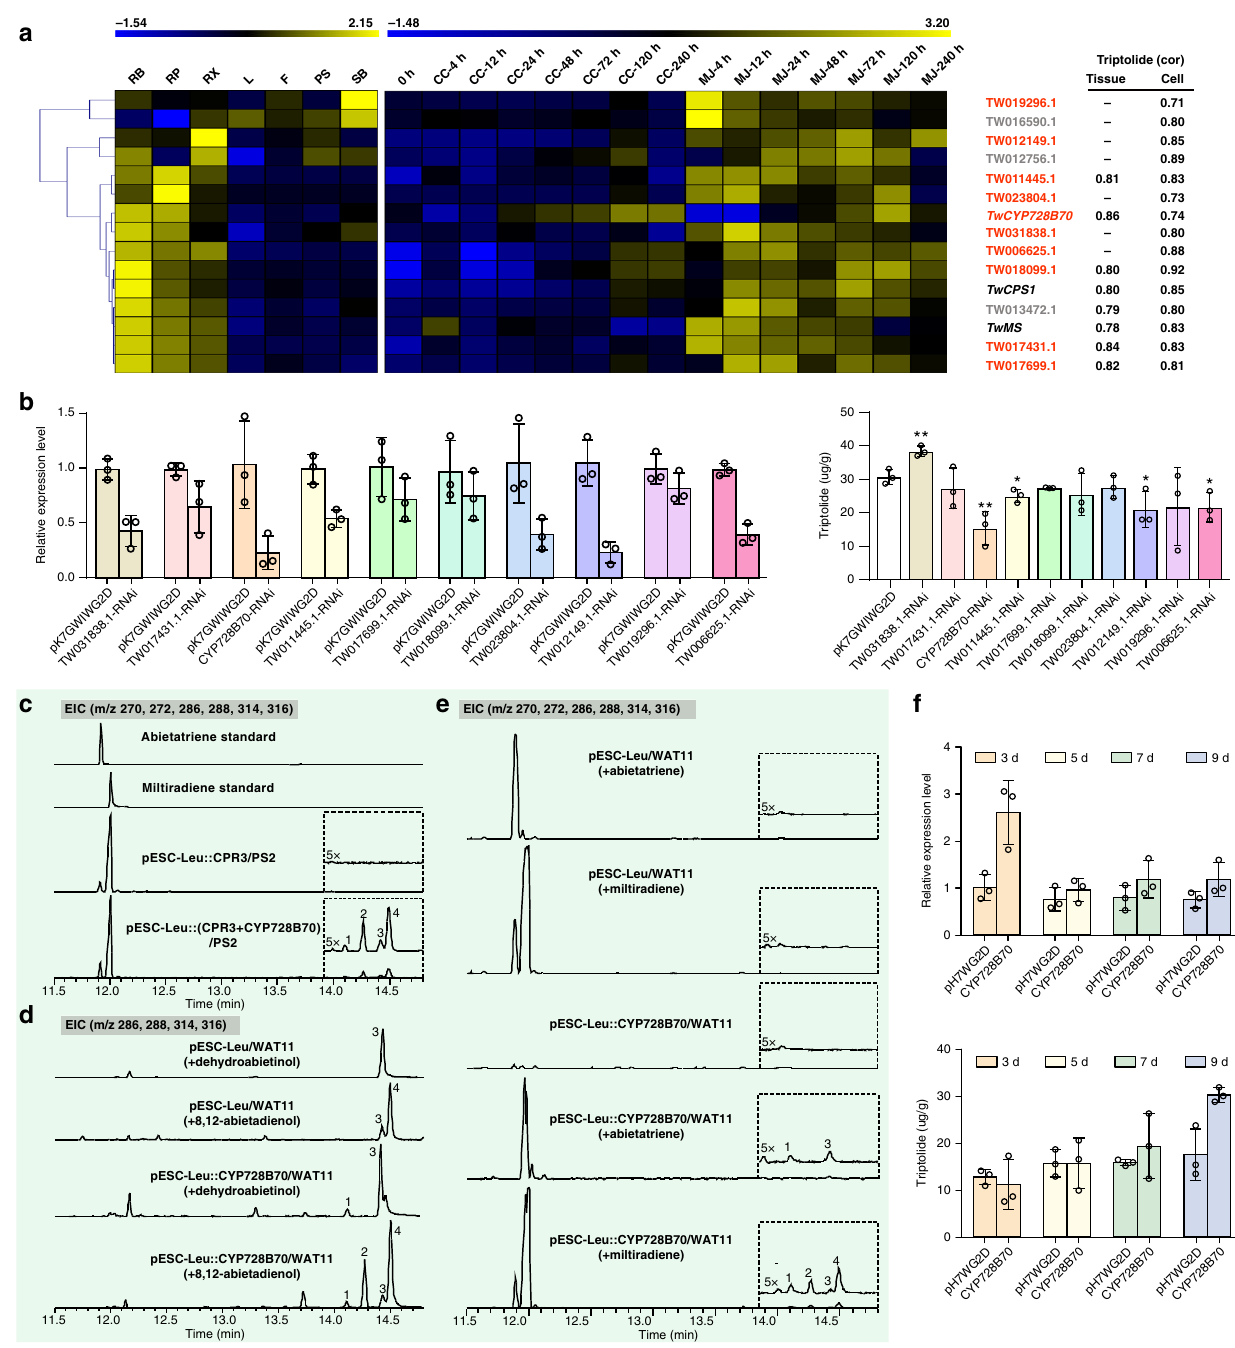
Fig. 3 CYP gene screening and functional identi fi cation of CYP728B70. a Hierarchical clustering of RNA-Seq expression data after fi ltering by expression level. b Relative expression of 10 candidate CYPs and triptolide concentration in RNAi suspension cells. c Co-expression of CYP728B70 and TwCPR3 in miltiradiene engineering yeast. d In vivo transformation of authentic diterpene alcohol substrates to the corresponding alcohols and acids in cultures of yeast cells expressing CYP728B70. e In vivo transformation of authentic diterpene substrates to the corresponding alcohols and acids in cultures of yeast cells expressing CYP728B70. f Relative expression of CYP728B70 , as well as triptolide concentration in CYP728B70-overexpressing suspension cells on the 3rd, 5th, 7th, 9th day. Error bars, mean ± SD ( n = 3 biologically independent samples; * P < 0.05, ** P < 0.01 by 2-sided Student ’ s t test). Source data underlying Figs. 3a, b, f are provided as a Source Data fi